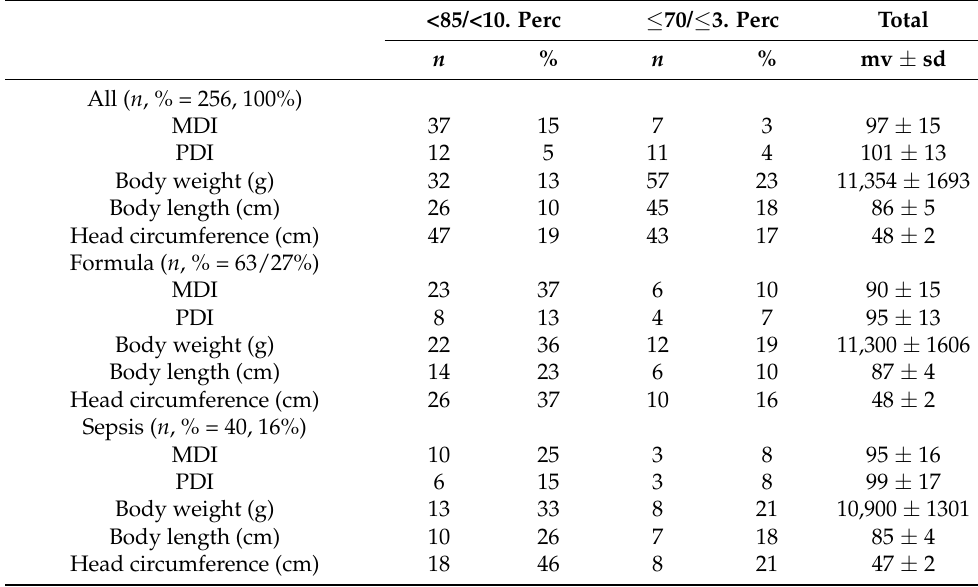
Table 2. Developmental deficits and outcome of all infants regarding risk factors at the age of 24 months in BSID-II.